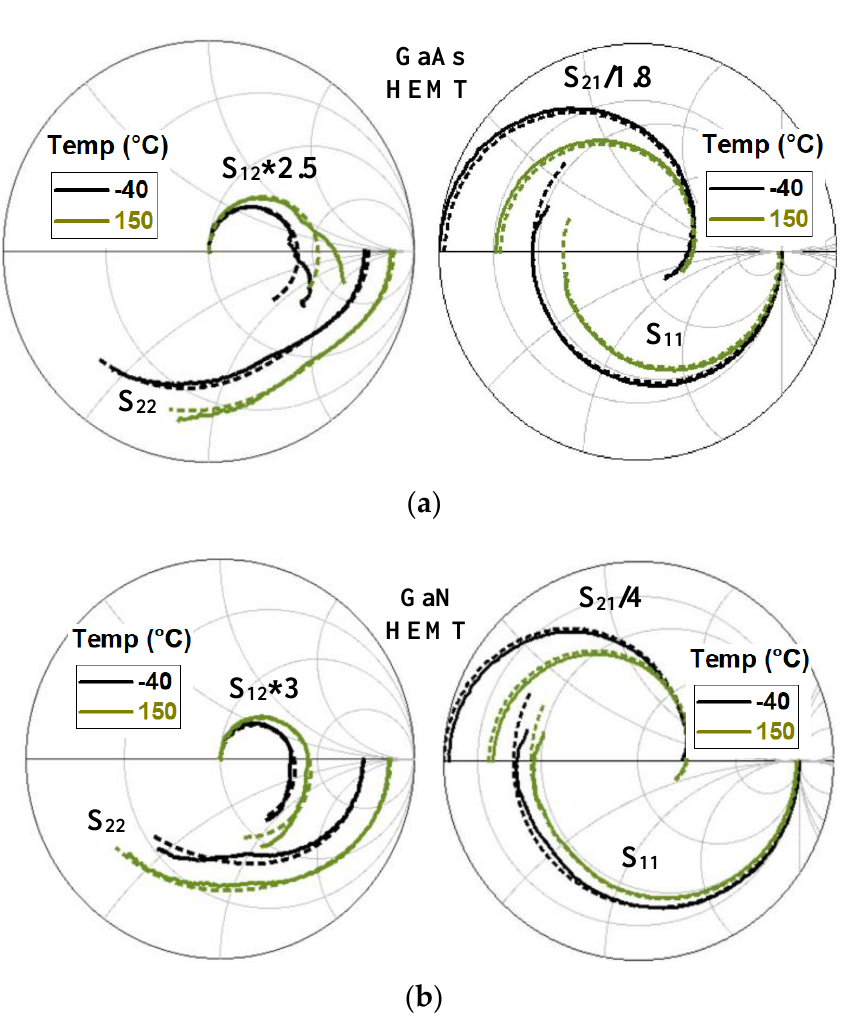
Figure 8. Measured S -parameters of the studied ( a ) GaAs and ( b ) GaN HEMTs at different T a . The illustrated bias points are: V ds = 3 V and V gs = −0 .1 V for the GaAs HEMT and V ds = 9 V and V gs = −4 V for the GaN HEMT. The frequency range goes from 45 MHz to 50 GHz. (“*” means product (the multiplication operation))